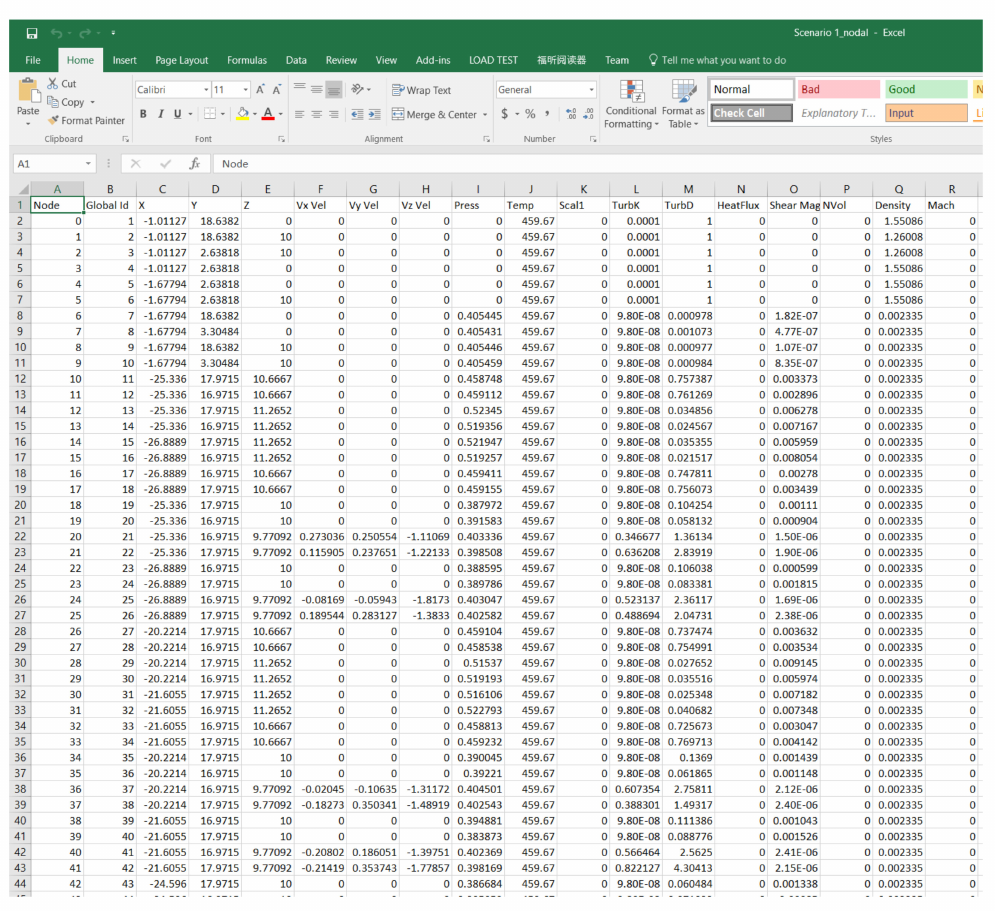
Figure 11. Nodal results from Autodesk CFD